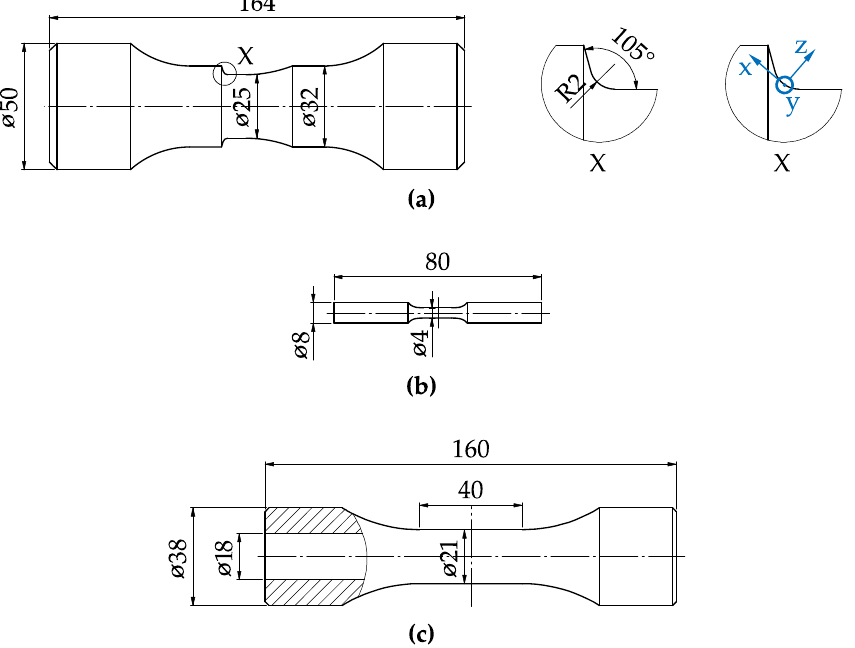
Figure 11. Specimen geometries used for fatigue tests with important dimensions: ( a ) notched specimen for load-controlled tests, ( b ) unnotched axial specimen for strain-controlled tests, ( c ) tubular unnotched specimen for normal and shear strain-controlled tests.